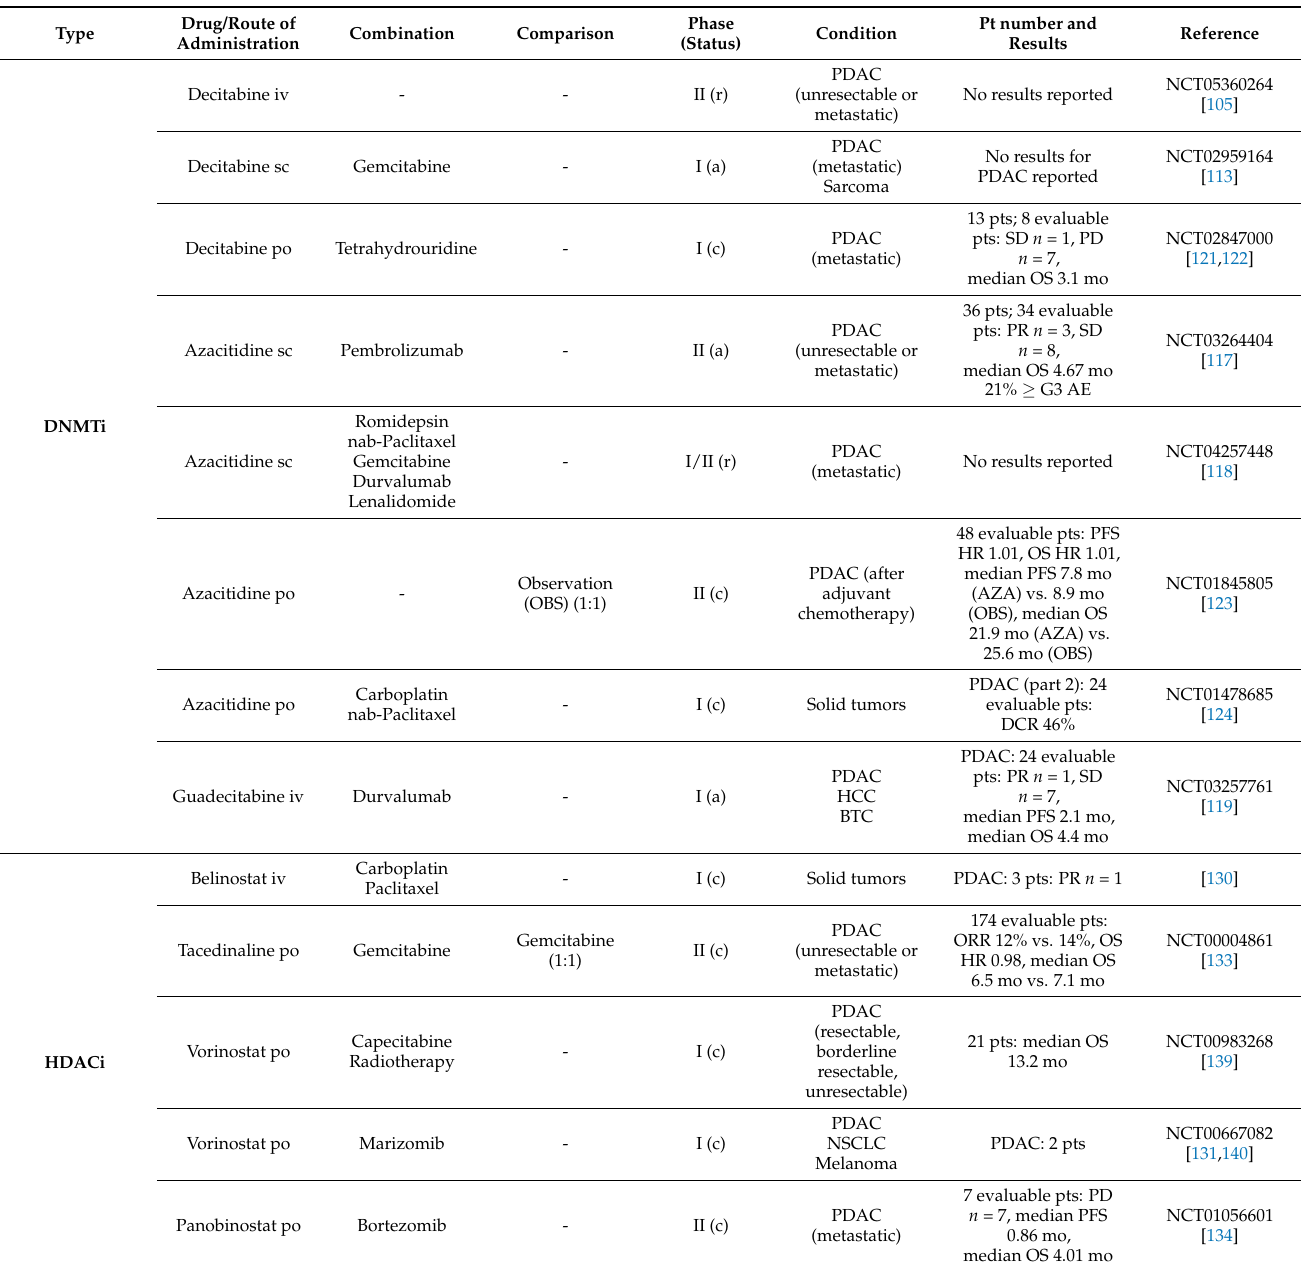
Table 2. Clinical trials evaluating epigenetic therapy in pancreatic cancer. The list may not be exhaustive, particularly since not yet published data of trials in solid tumors do not allow conclusions on the number of patients enrolled with pancreatic